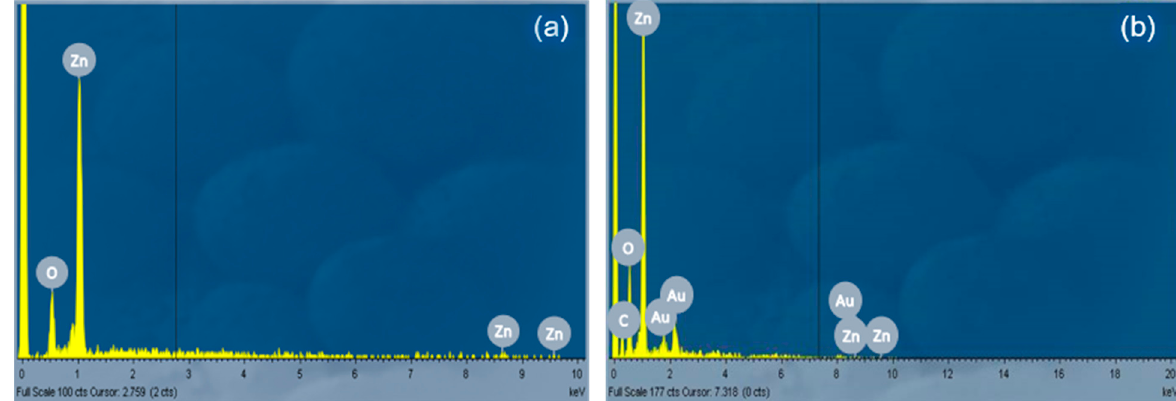
Figure 3. ( a ) Energy dispersive X-ray spectroscopy (EDS) patterns of bare ZnO NRs and ( b ) ZnO NRs/Au NPs, confirming the existence of Zn, O, and Au, and revealing the successful formation of ZnO NRs and Au NPs decoration.